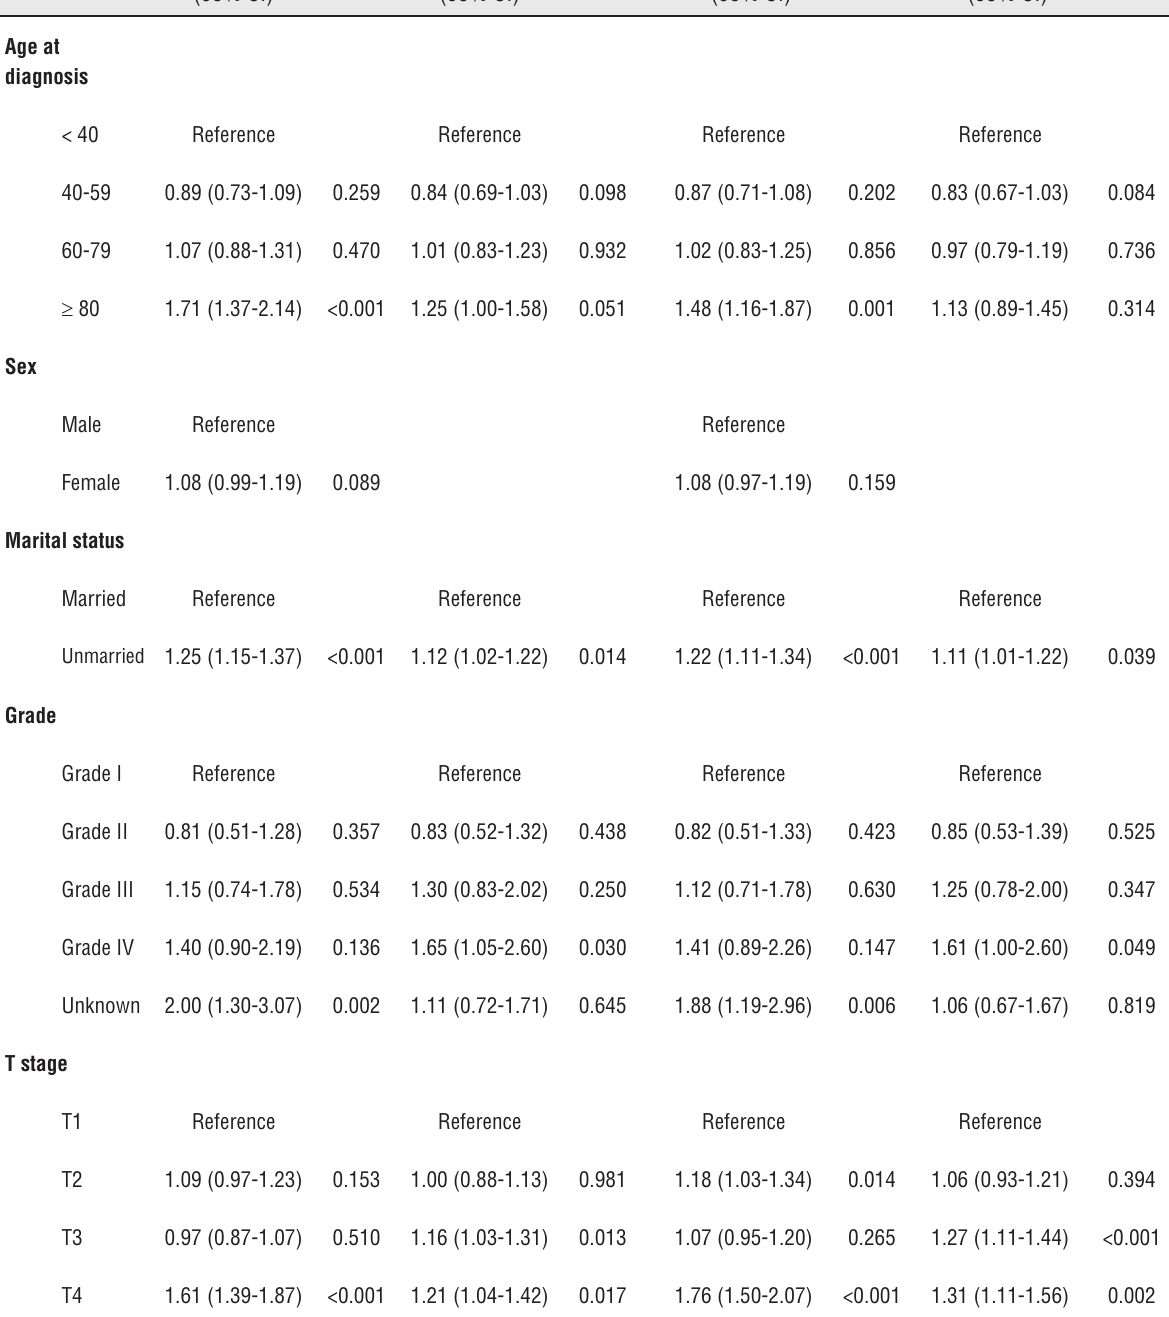
Table 2 - Univariate and multivariate analysis of overall survival (OS) and cancer-specific survival (CSS) rates. OS CSS Characteristic Univariate analysis Multivariate analysisa Univariate analysis Multivariate analysisb Hazard Ratio P value Hazard Ratio P value Hazard Ratio P value Hazard Ratio P (95% CI) (95% CI) (95% CI) (95% CI)